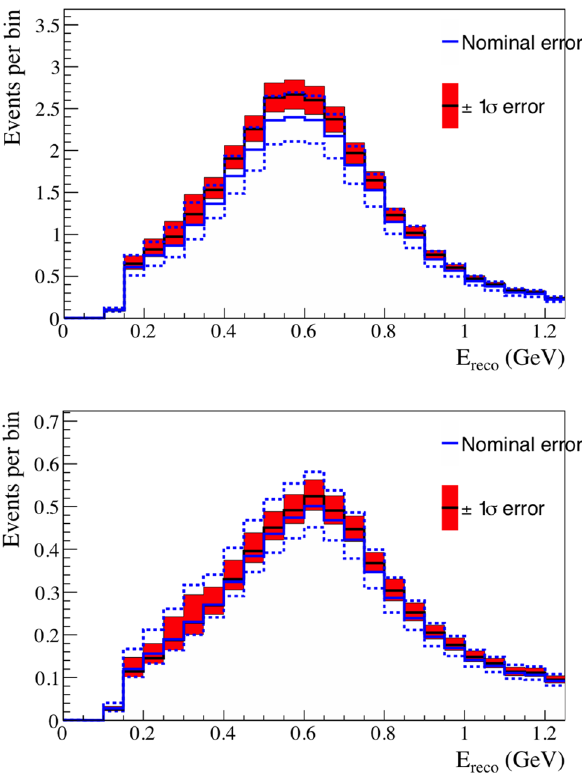
Fig. 69 The expected energy spectra of electron events in SK in neu- trino beam mode (top) and anti-neutrino beam mode (bottom). The dashed histograms represent the ± 1 σ error without near detector con- straints, while the solid histogram shows the error with near detector constraints ND280 constraint. Without constraints by the ND280 mea- surements, the error size increases up to 12–14%.